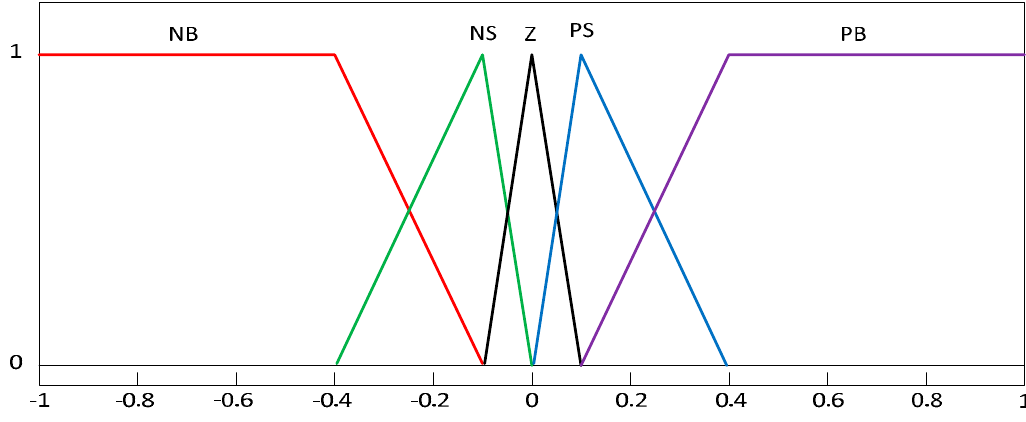
Figure 3. Schematic of membership functions (MFs) for inputs and outputs.